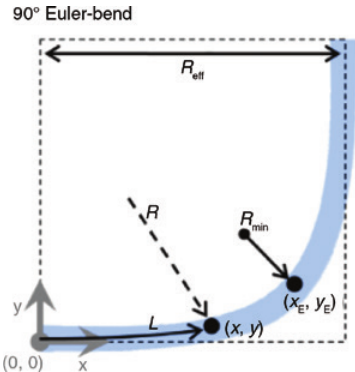
Figure 6: A 90 ° Euler-bend composed of a pair of 45 ° modified Euler-curves with a maximum curvature radius R point (0, 0) and a minimum curvature radius R ( x , y ) [94]. E E